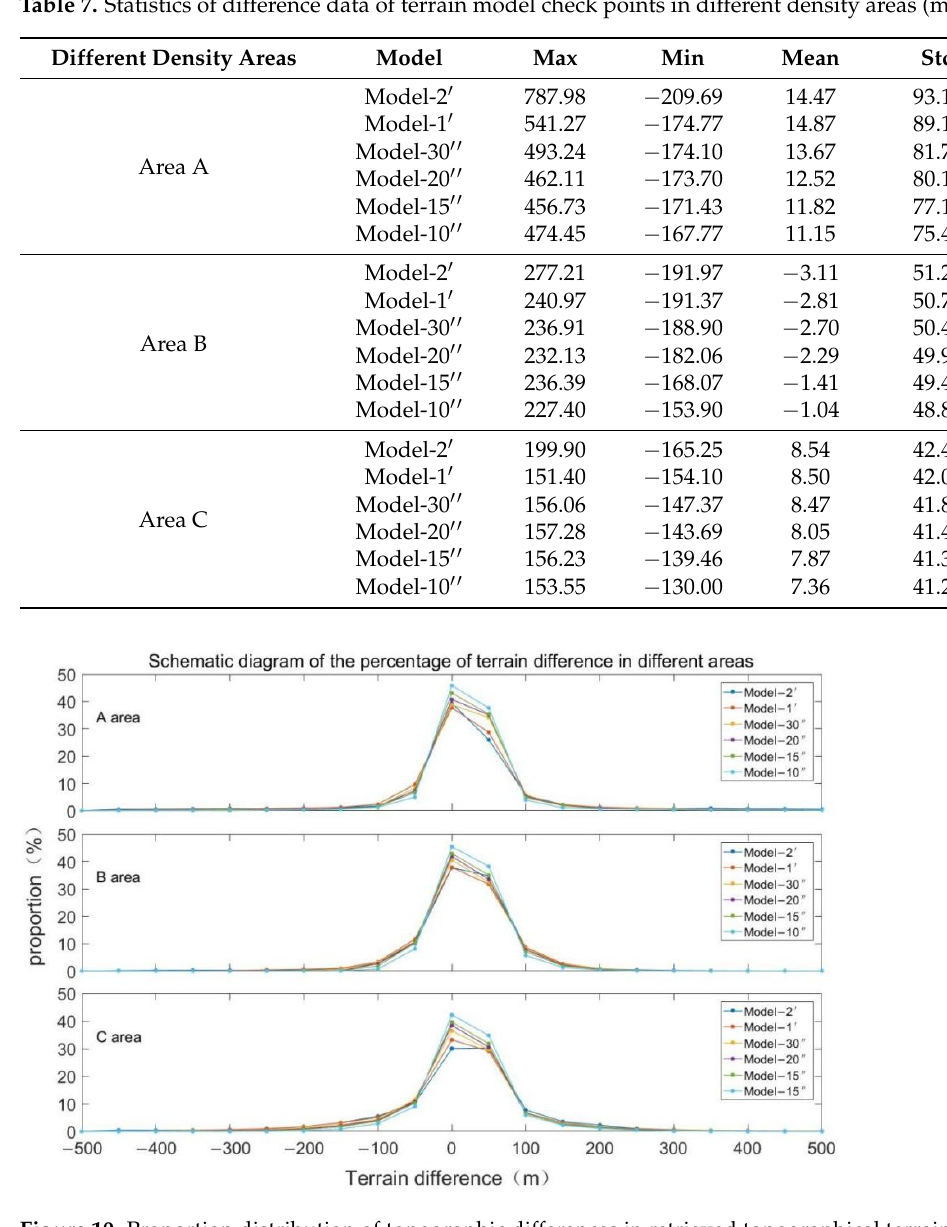
Figure 10. Proportion distribution of topographic differences in retrieved topographical terrain with different resolutions in different density areas.